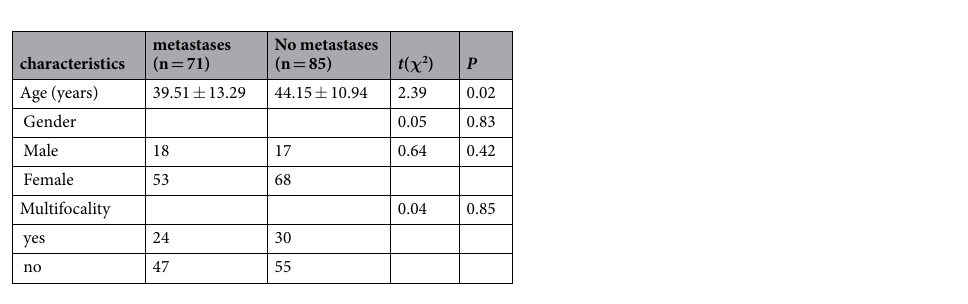
Figure 2. PTC without cervical LNM. A hypoechoic nodule with ill-defined margin and regular shape was found at the upper pole of the right thyroid lobe in a 44-year-old male PTC patient ( A ). The size of nodule was 0.6 cm × 0.5 cm × 0.6 cm. CEUS showed a slight low-enhancement in the nodule (arrow), and the thyroid capsule was intact ( B ). Weak expression ( + ) (arrow) of matrix metalloproteinase-9 was found in the cytoplasm of the malignant cells of a PTC sample, as shown by the brown staining (arrow) (magnification, × 200) ( C ). Surgical results: PTC without cervical LNM.